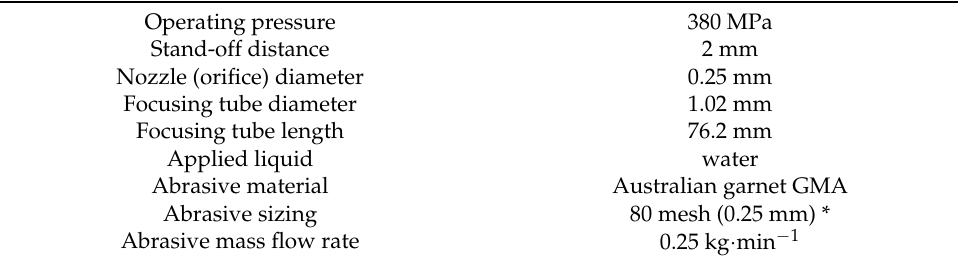
Table 2. The AWJ settings used in